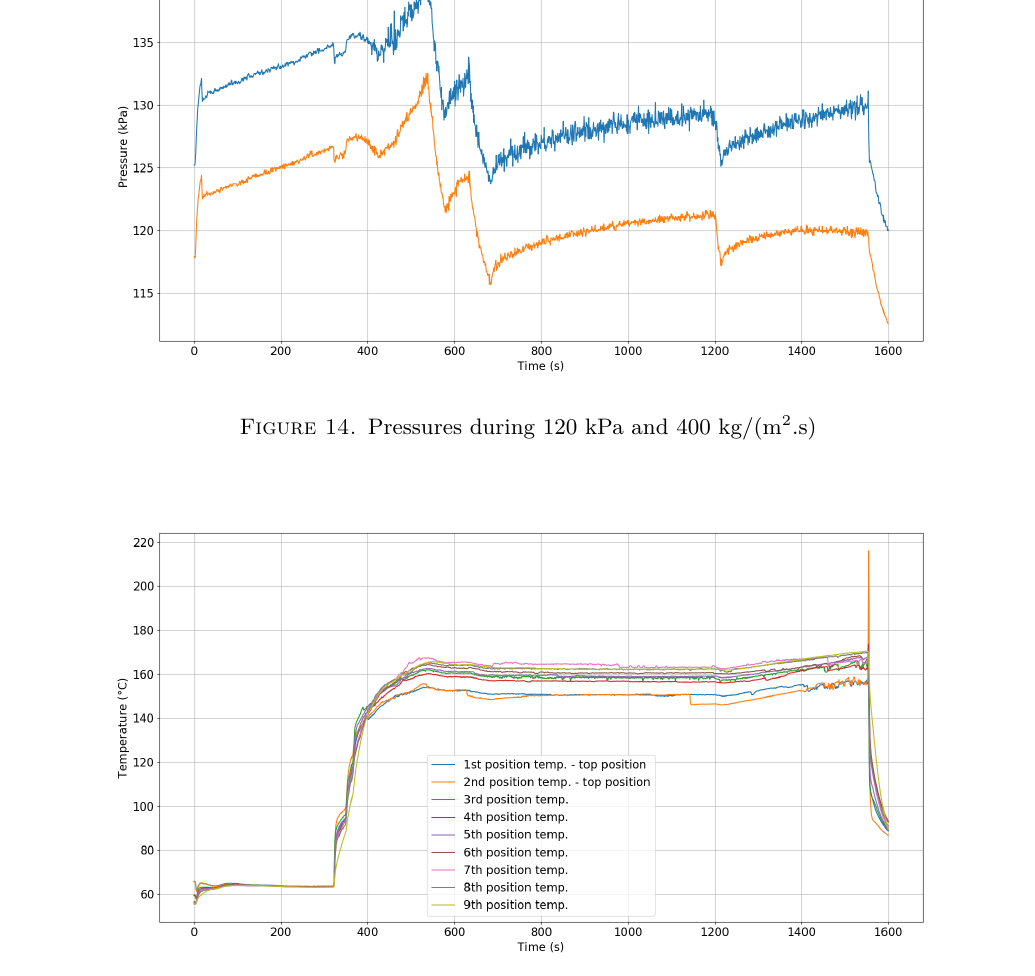
Figure 15. Temperatures during 120 kPa and 400 kg/(m 2 . s)